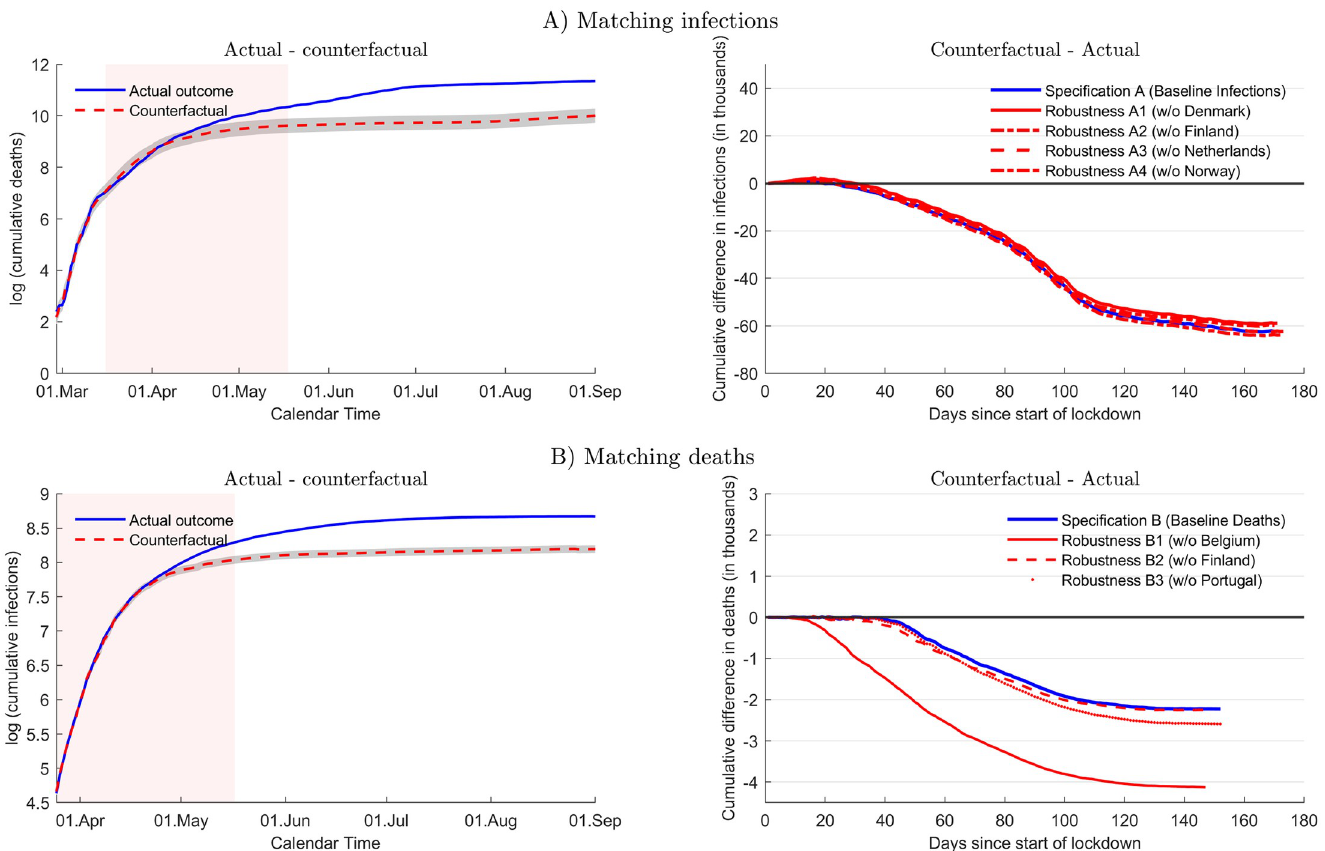
Fig 1. COVID-19 infections in Sweden. Top-left panel compares actual infections (blue solid line) and control unit/counterfactual (red dashed line) in logs for baseline Specification A. Top-right panel shows difference of infections between counterfactual and actual outcome in thousands. Table 1 reports country weights for control unit counterfactual (Specification A (baseline)). Gray shaded area shows two standard deviations of difference between infections in Sweden and control unit during the first 13 days (matching period). Pink shaded area: lockdown period (March 15–May 17). Specifications (A1–A4): alternative control units based on restricted donor pools. Bottom panels organized in the same way, but for Specification